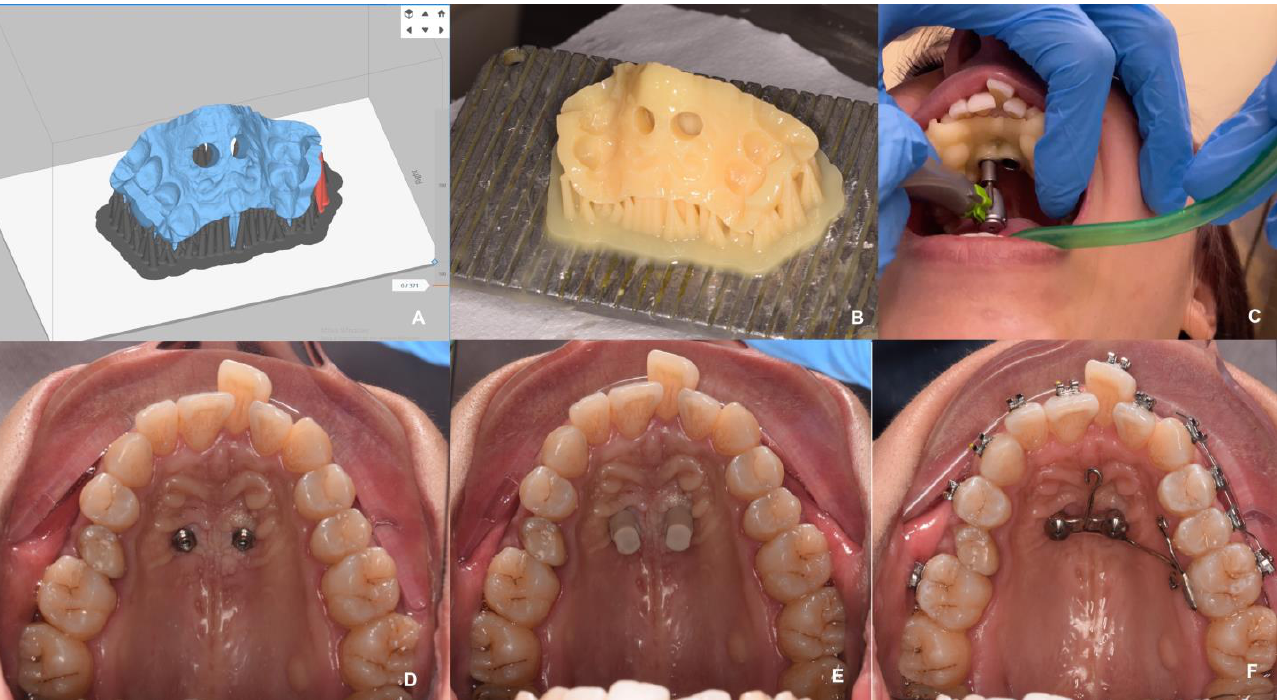
Figure 14. Clinical example of miniscrews placement with 3D printed guided systems. ( A ), Digital guide in the digital 3D printing plate; ( B ), 3D printed surgical guide; ( C ), clinical procedure of miniscrew insertion; ( D ), miniscrews placed in the palatal paramedian region; ( E ), scanbodies for intra-oral scan; ( F ), appliance fixed to the miniscrews.